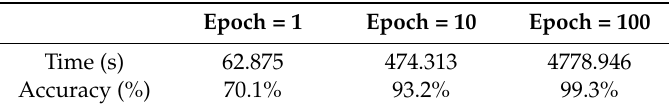
Table 9. Training time of different epochs.